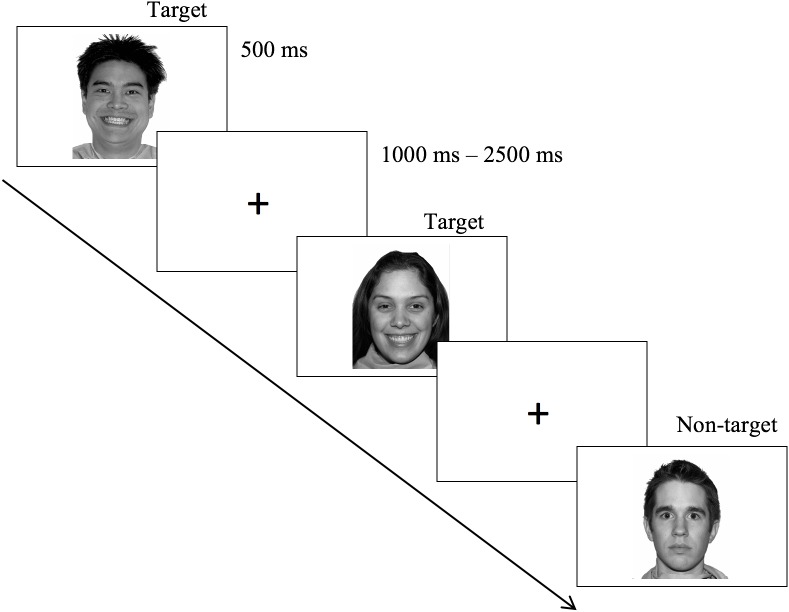
Schematic of emotional Go/No-go task. Example happy/neutral block. Target = “Go” stimulus, Non-target = “No-go” stimulus. Each block contained 35 targets and 13 non-targets. Stimuli are from the NimStim set of facial expressions (Tottenham et al., 2009). Actors provided written informed consent for the publication of these images. No copyright permissions are required for the use of these images.